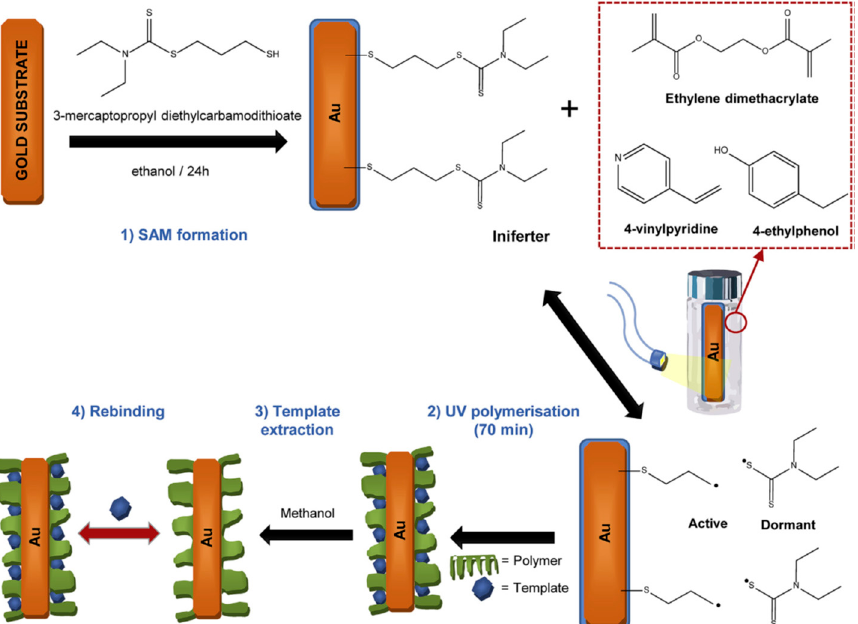
Figure 18. Schematic illustration of the followed whole procedure to develop the MIP sensor. ( 1 ) Immobilization of the thiol iniferter on a gold substrate. Immersion of the iniferter-coated gold microelectrode in the polymerization solution. ( 2 ) Coating of the gold microelectrode with an MIP thin layer. Polymerization was initiated by UV radiation. ( 3 ) Template molecule extraction using methanol. ( 4 ) Template rebinding was avoided by replacing the extracting medium every 5 min. Reprinted from [64], with permission from Elsevier, 2018.